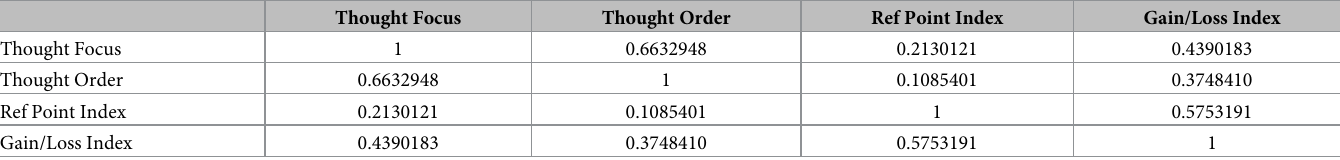
Table 1. Correlations of predictor